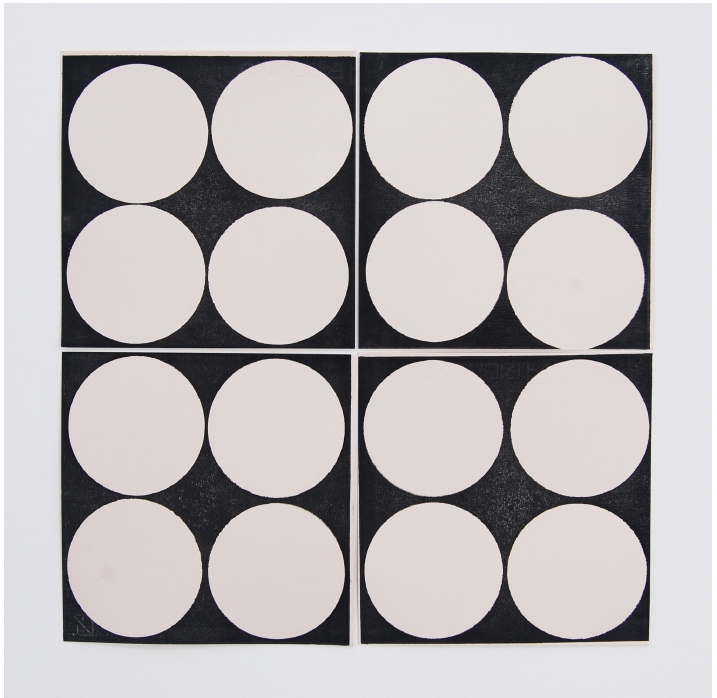
Figure 1: Katrina Blannin, Four by Four , 2016. Collograph polyptych: handmade ink on paper 20 x 20cm. Copyright